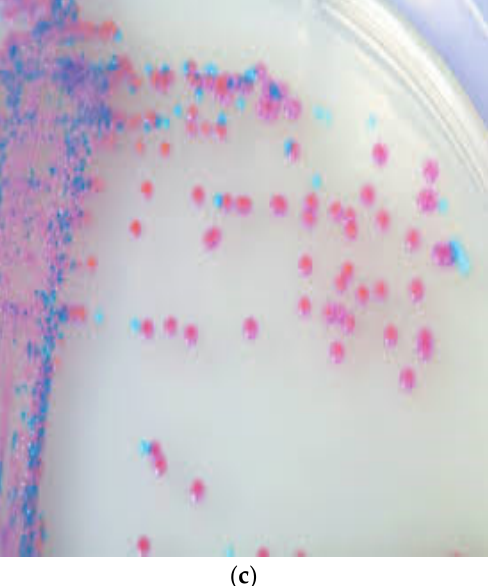
Figure 1. Colony morphology of S . pseudintermedius and its differentiation from S . aureus . (a) Creamy grey-to-white colonies of S . pseudintermedius on Columbia sheep blood agar. ( b ) S . aureus growth on Columbia sheep blood agar. ( c ) Mixed culture of Staphylococci on CHROMagar Staph aureus TM (Oxoid, UK). Tiny blue colonies are S . pseudintermedius , while pink to mauve colonies are S . aureus . Table 1. Phenotypic Identification of S . pseudintermedius and its differentiation from S . aureus . Test